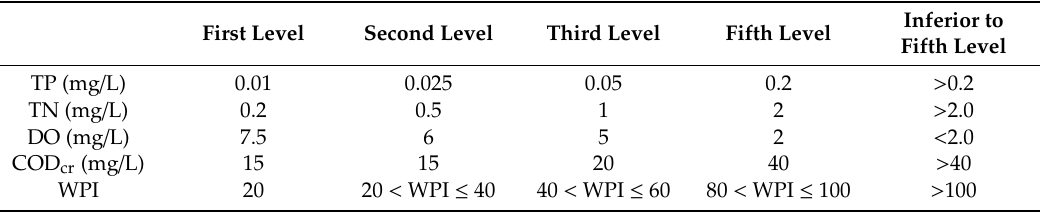
Table 2. China’s national water quality standards for total nitrogen (TN), total phosphorus (TP), chemical oxygen demand (COD), and dissolved oxygen (DO) and their corresponding water pollution index (WPI)